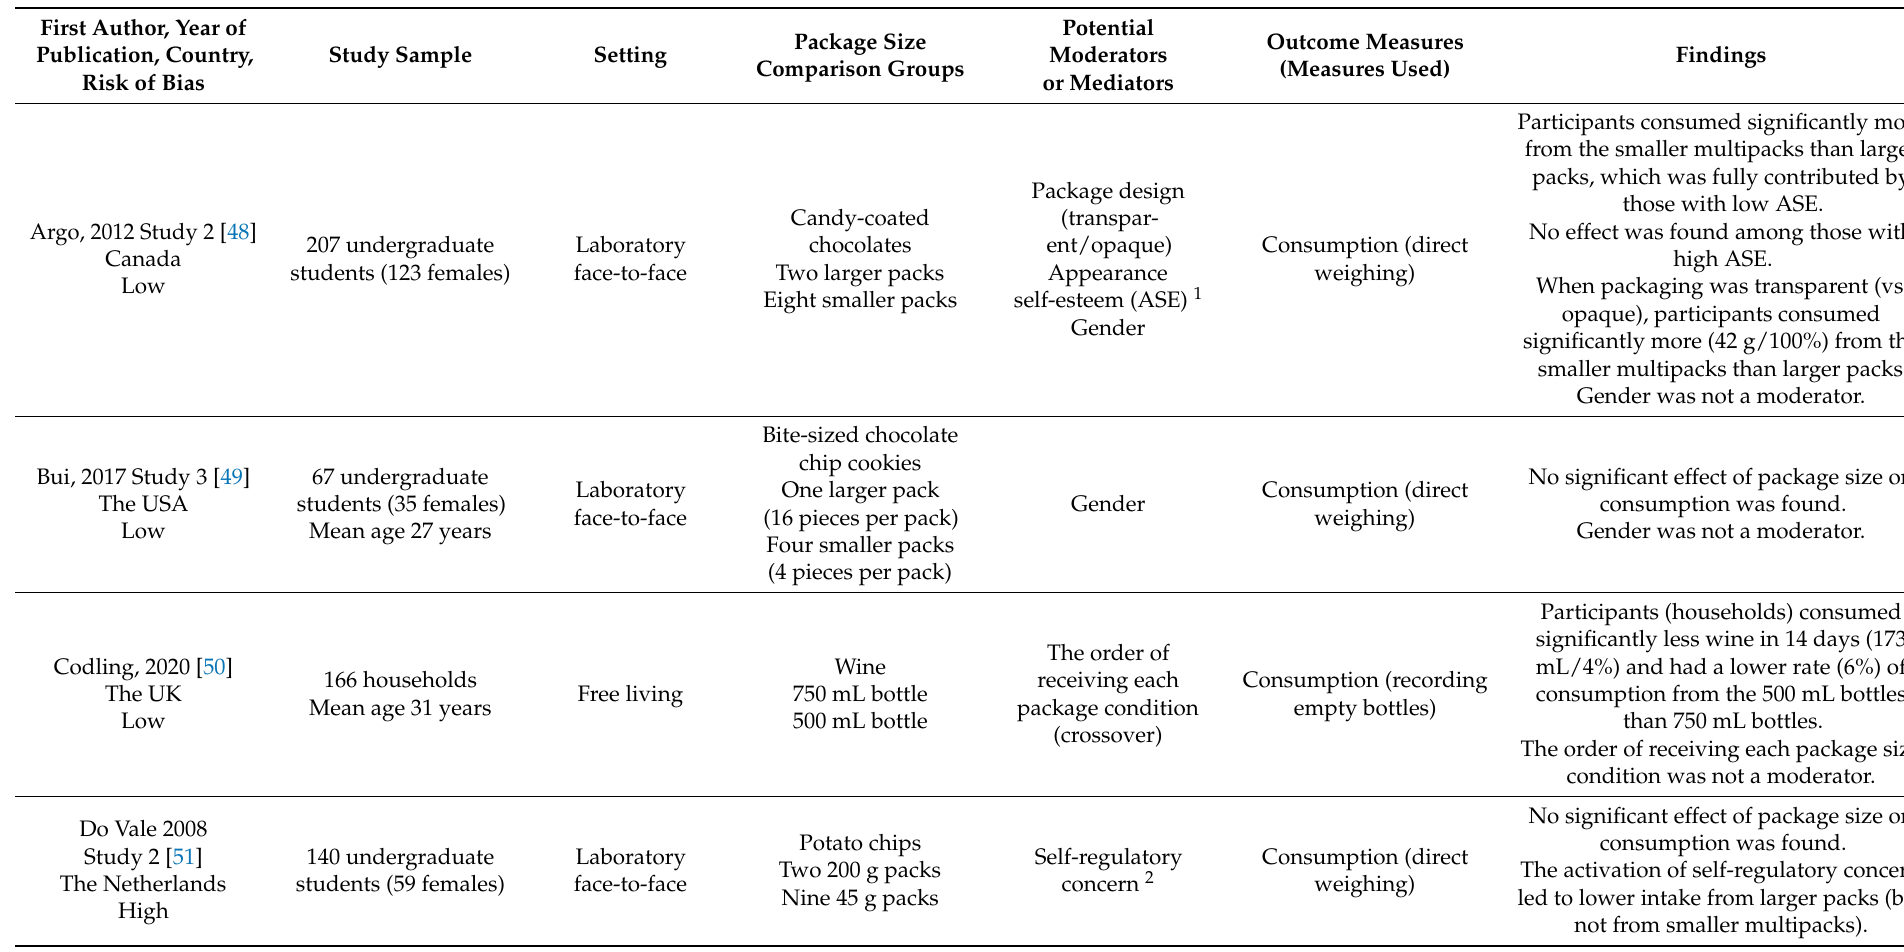
Table 3. Summary of intervention studies comparing smaller multipacks versus larger package(s) containing same total serving size of energy-dense, nutrient-poor snack and